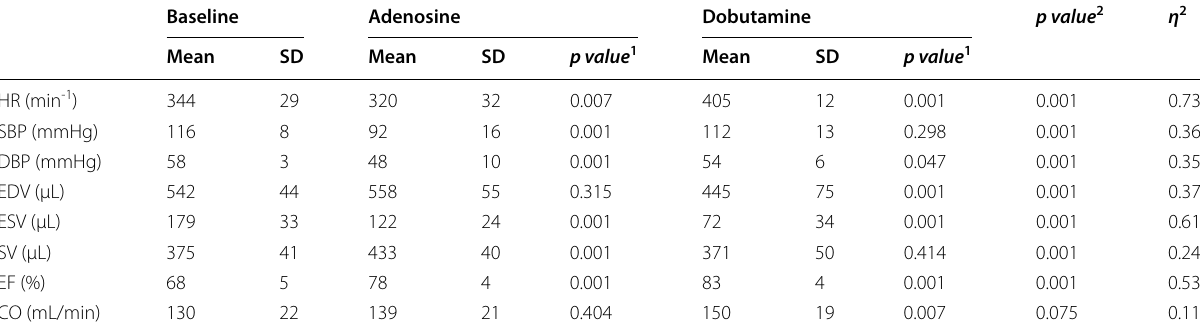
Table 1 Hemodynamic and left ventricular parameters derived by transthoracic echocardiography at baseline and under stimulation with adenosine or dobutamine in eight